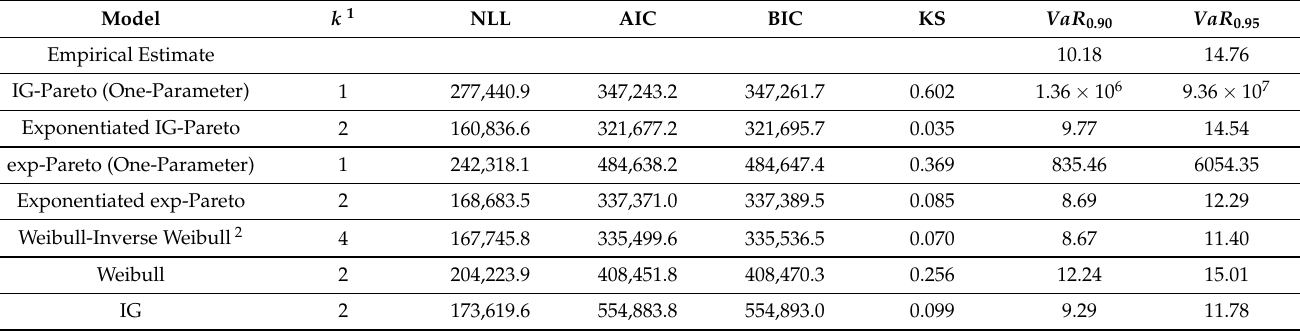
Table 7. Comparisons of different models, with the SOA group medical claims insurance data, for